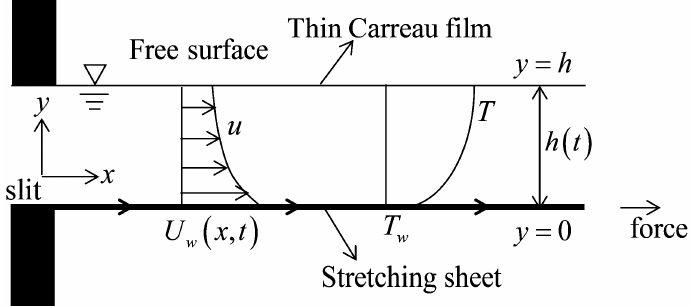
Figure 1. Schematic diagram of the thin film flow along a stretching sheet.